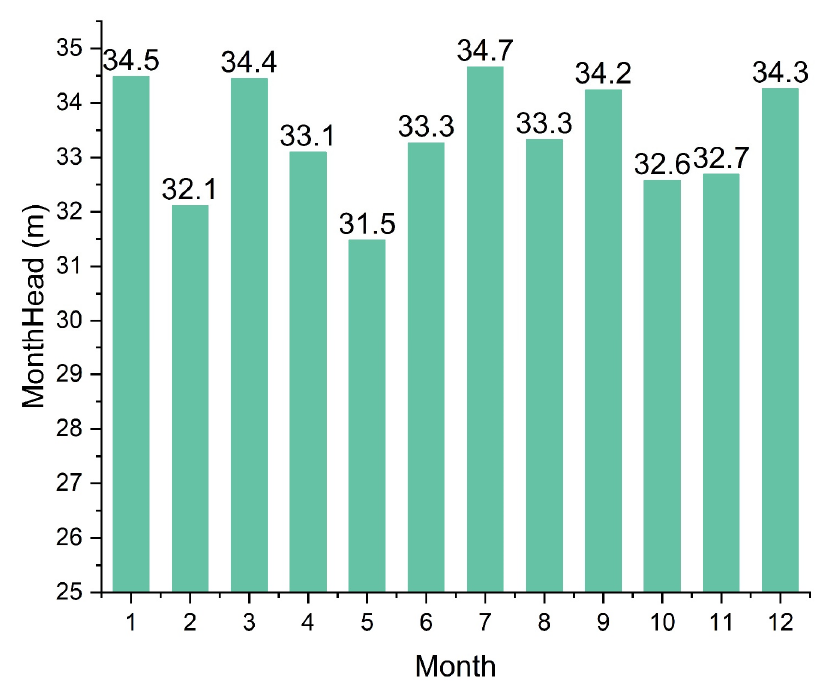
Figure 3. Average monthly groundwater level during 1977–2017 in the Gnangara region.